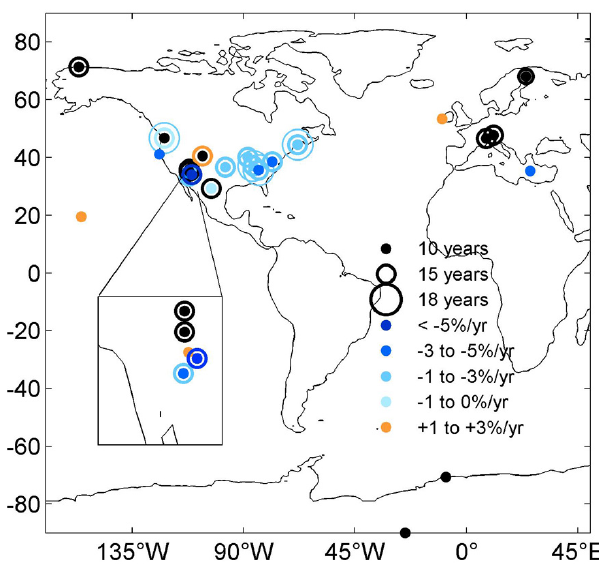
Fig. 4. MK trends results for the scattering coefficient. Black sym- bols correspond to stations with no significant trends. Blue and or- ange symbols correspond to statistically significant negative and positive trends, respectively, the magnitude of the trends (slope) be- ing given by the colors as stipulated in the legend. The sizes of the circles are proportional to the length of the data sets; the trend for the whole period as well as the 10yr (dots) and, if possible, 15yr trends were calculated. The largest circles denote, therefore, the trend of the longest analyzed